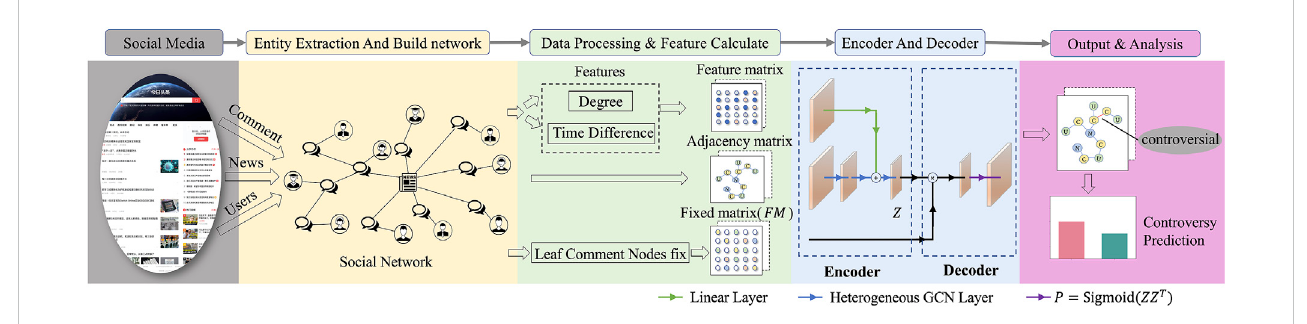
FIGURE 6 Architecture of our framework, including graph constructing and model of the news – comment – user graph convolutional network (NCU-GCN). Z represents the embedding vectors obtained from the encoder